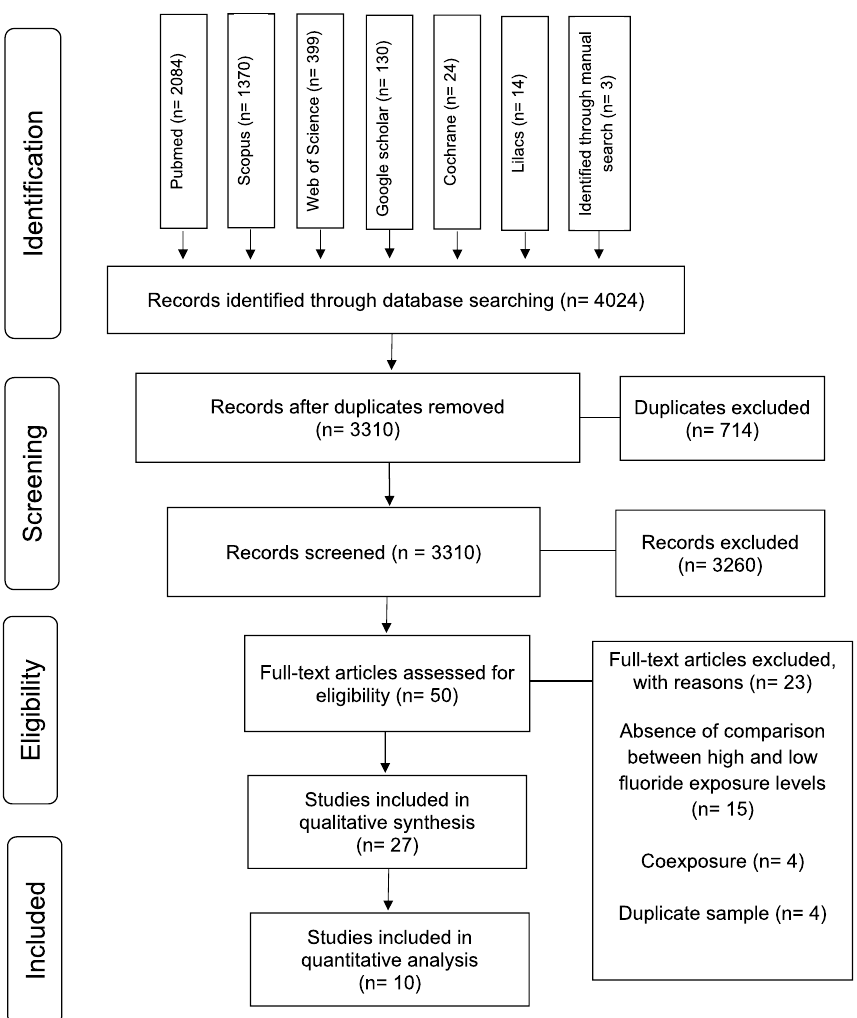
Figure 1. Flow diagram of databases searched according to PRISMA guidelines. PRISMA, Preferred Reporting Items for Systematic Review and